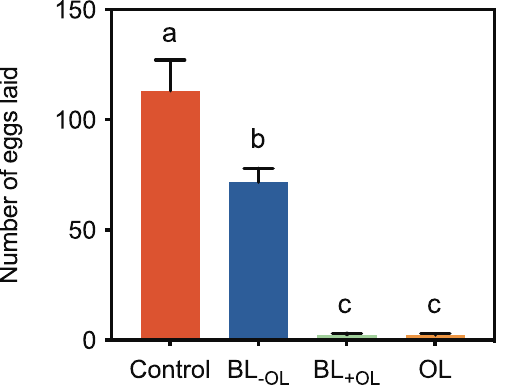
Figure 4. 1-octanol inhibited oviposition by gravid B. tryoni females. Gravid females were presented with agarose plates containing oviposition stimulant (OS) alone (control), agarose plates containing OS + synthetic blend of headspace volatiles excluding 1-octanol (BL −OL ), agarose plates containing OS + synthetic blend of headspace volatiles including 1-octanol (BL +OL ) and agarose plates containing OS + 1-octanol (OL). Significantly more eggs were laid into control and BL −OL than into BL +OL and OL. Error bars represent s.e.m. Significant difference is denoted by different letters (ANOVA followed by Tukey’s test; P < 0.001; n = 10; see Results